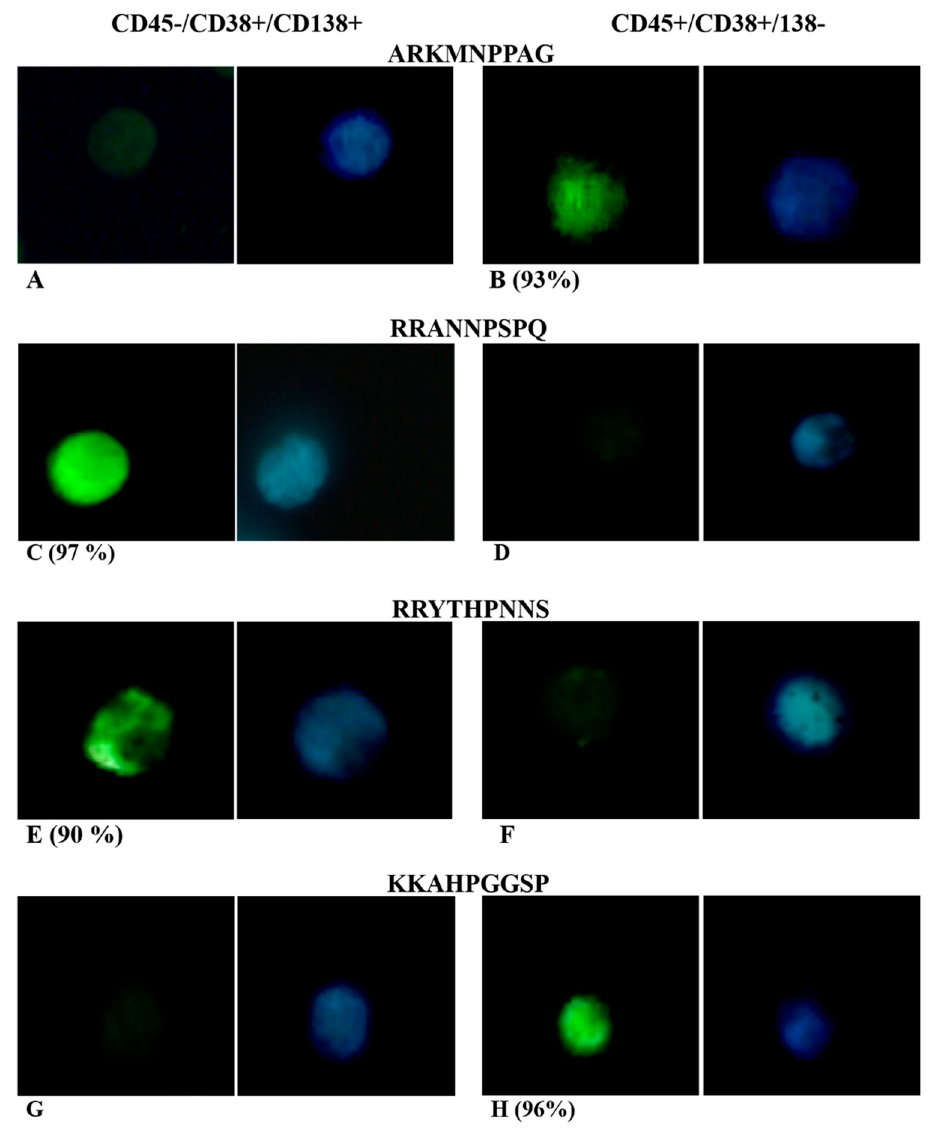
Figure 3. Ex-vivo fluorescence test of ARKMNPPAG ( A , B ), RRANNPSPQ ( C , D ), RRYTHPNNS ( E , F ), and KKAHPGGSP ( G , H ) FITC-labelled phage incubated with MM cell sorted using CD45, CD38, CD138 gates. Green fluorescence was due to FITC-labelled phage, while blue fluorescence was due to DAPI nucleus staining. Percentage in brackets refers to only cells with evident green fluorescence due to phage clone binding.